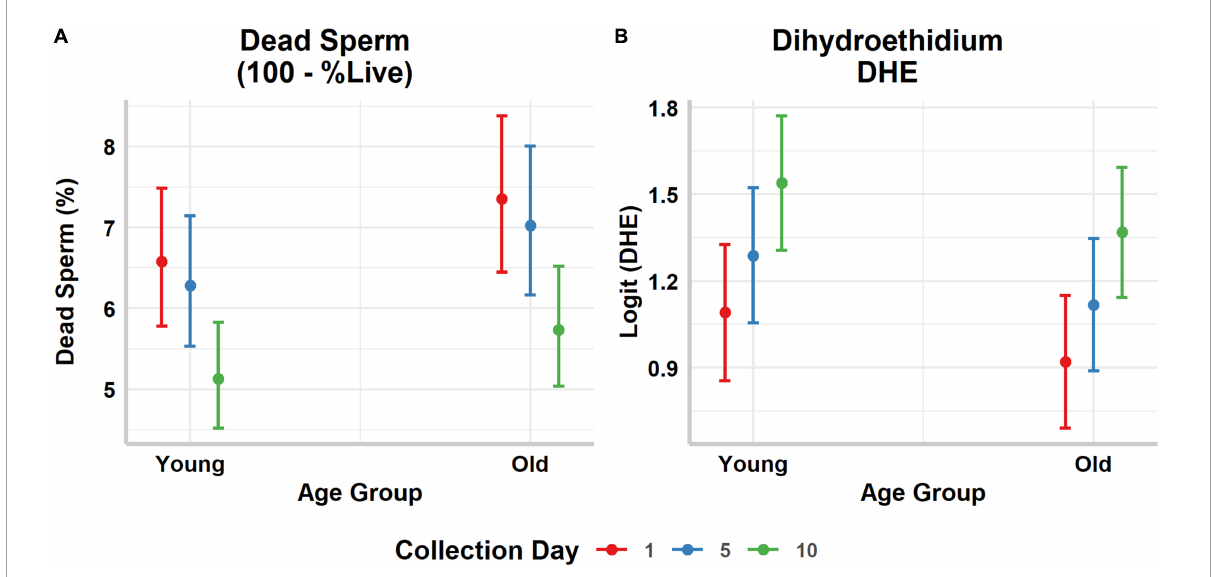
FIGURE2 Predicted marginal means and their corresponding 95% confidence intervals of the (A) percentage of dead sperm, (B) and the percentage of DHE positive sperm (on the logit scale), per male (old vs. young) and sperm age. Collection day refers to the day sperm was collected after a common initial collection, and it is used as a proxy of sperm